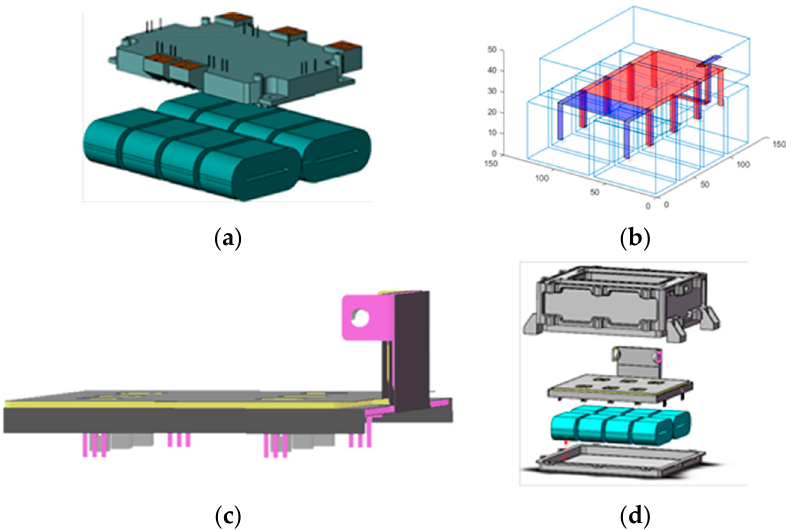
Figure 13. ( a ) Layout of bus capacitance and power modules; ( b ) Results of automatic bus design; ( c ) 3D model of the actual bus designed according to the results of the automatic bus design; ( d ) Explosion diagram of the entire motor controller.